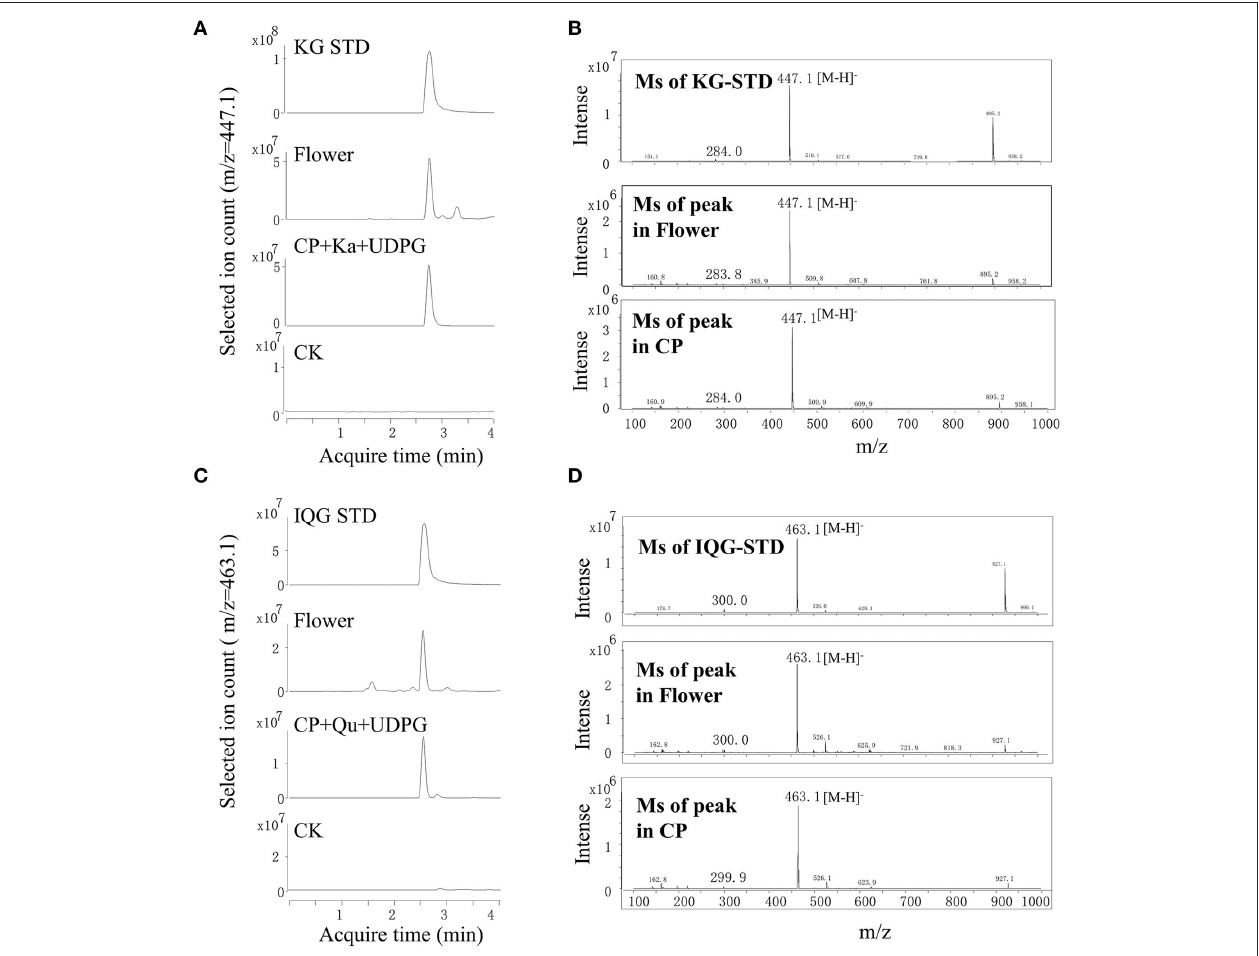
FIGURE 3 | Crude proteins from flowers catalyzed the formation of astragalin and isoquercitrin in vitro . (A,B) UPLC-MS chromatograms of extracts from flowers and crude proteins (CP) with kaempferol (Ka). (C,D) UPLC-MS spectra of extracts from flowers and CP with isoquercitrin (IQG).